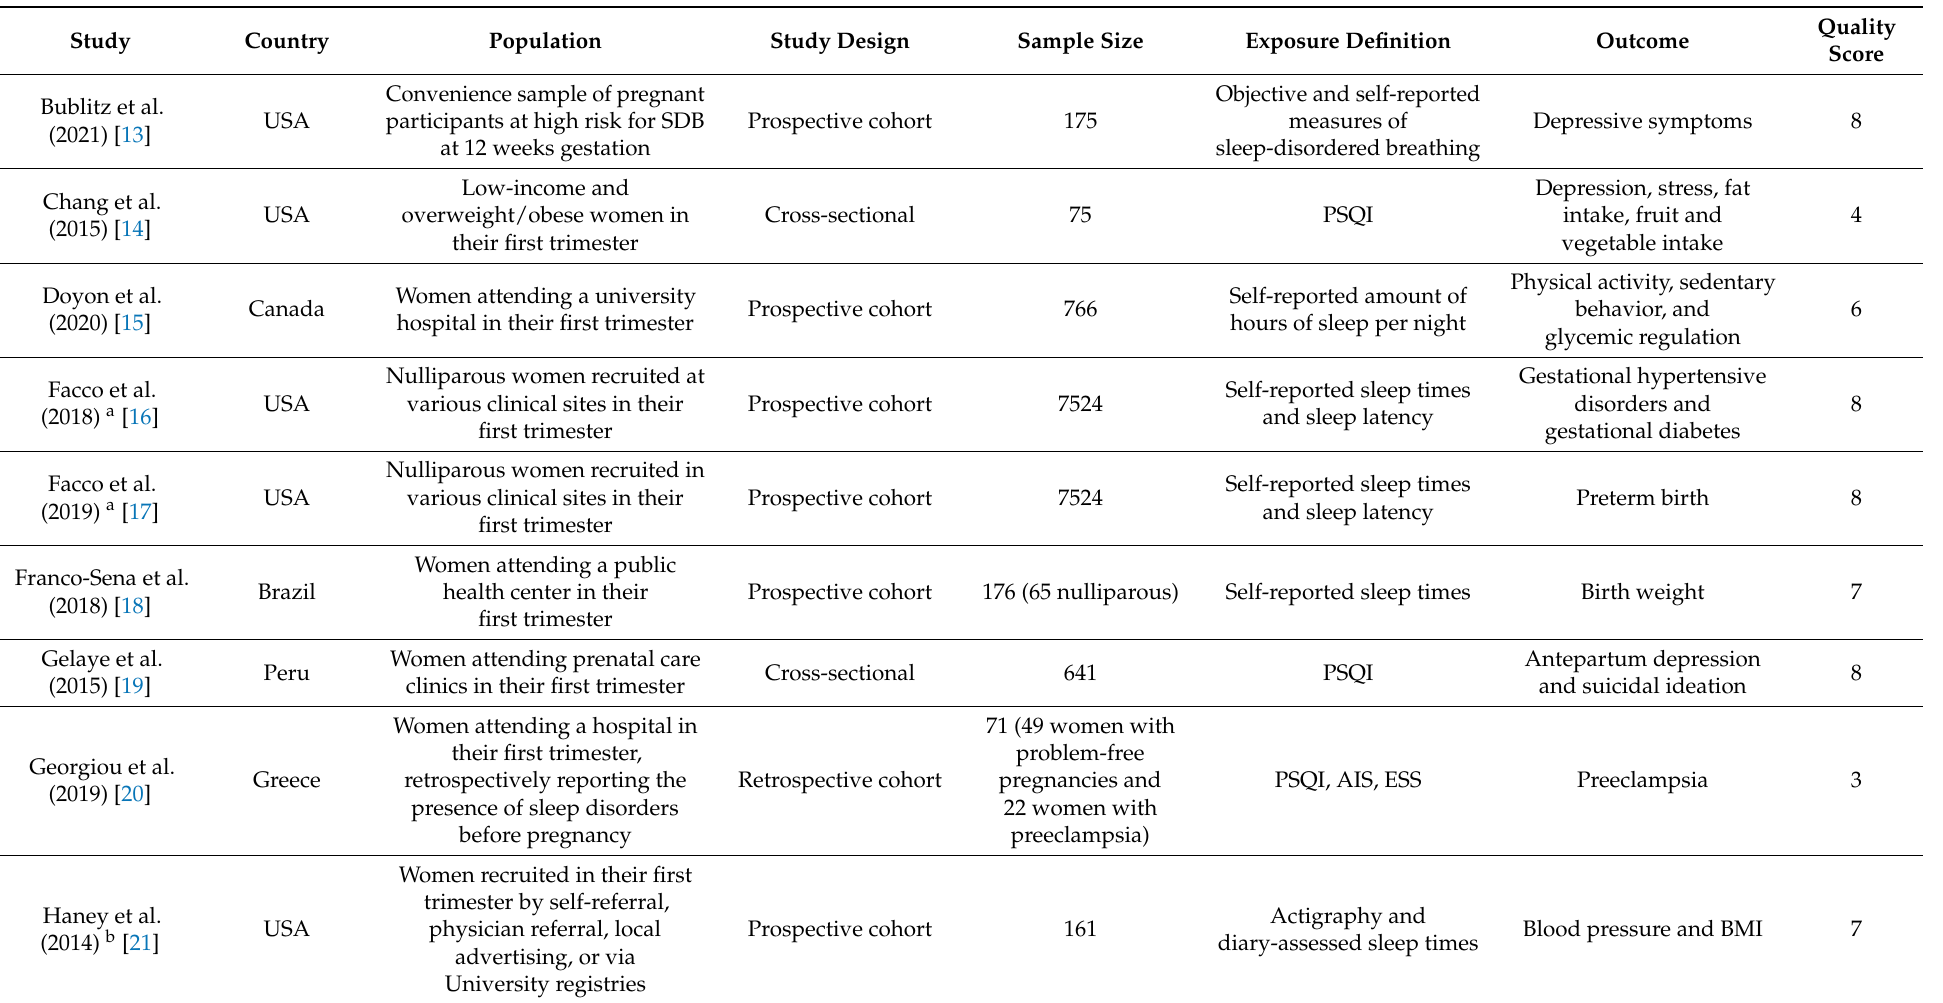
Table 1. Overview of characteristics of included studies in the systematic review (N =